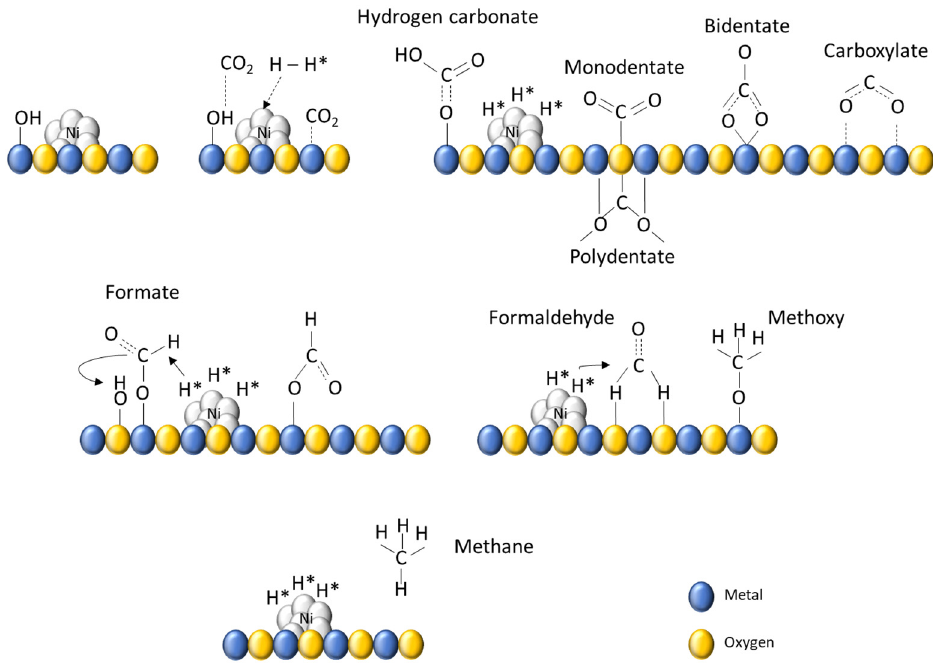
Figure 11. Scheme illustrating the formate pathway for CO 2 methanation on supported Ni cata-